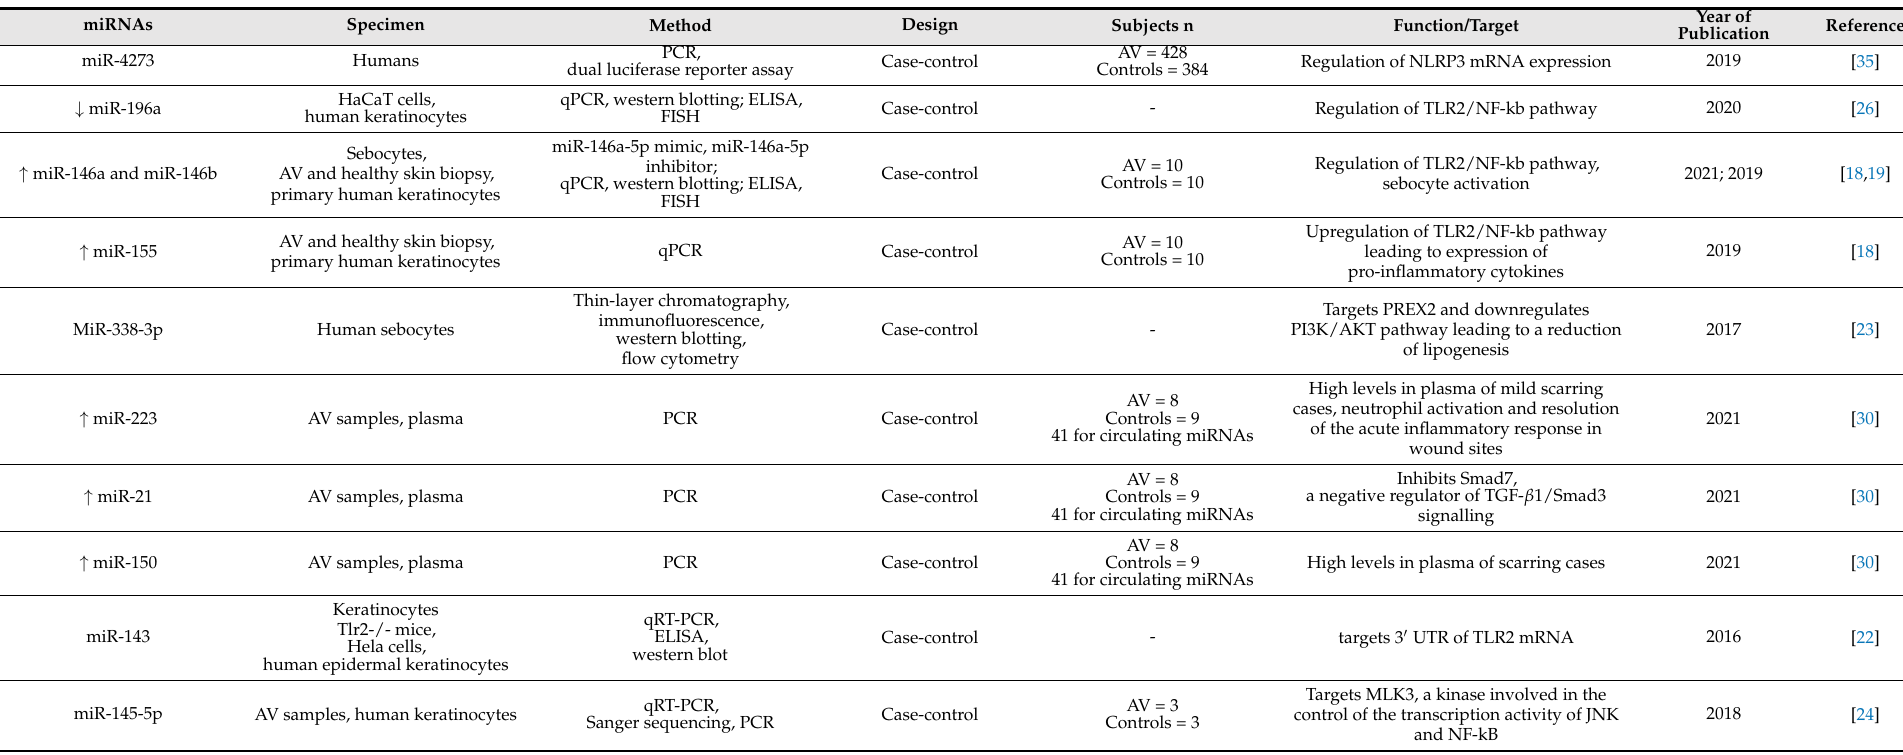
Table 1. MiRNAs, type of cells, method, design, number of subjects, function, target, year of publication and final effect on inflammation in